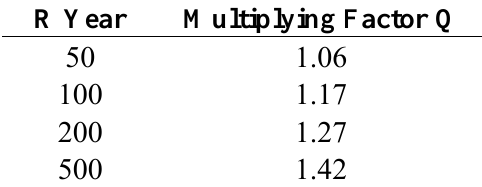
Table 2. Multiplying factor Q for the conversion of the R-year recurrence